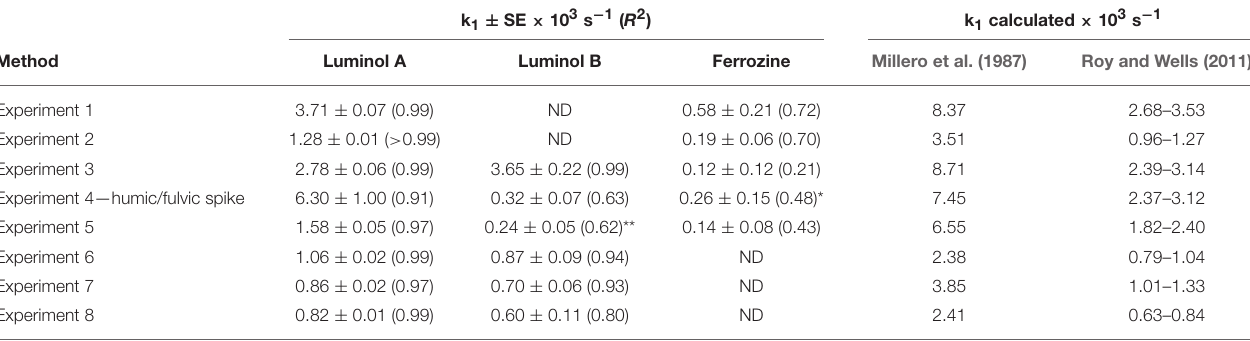
TABLE 4 | A comparison of different methods for determining Fe(II) concentrations, which should not be affected by the measurement time offset between different methods, was made by deriving the apparent Fe(II) oxidation constant (k 1 ). SE, the standard error, (and R 2 ) is also shown for the linear regression.